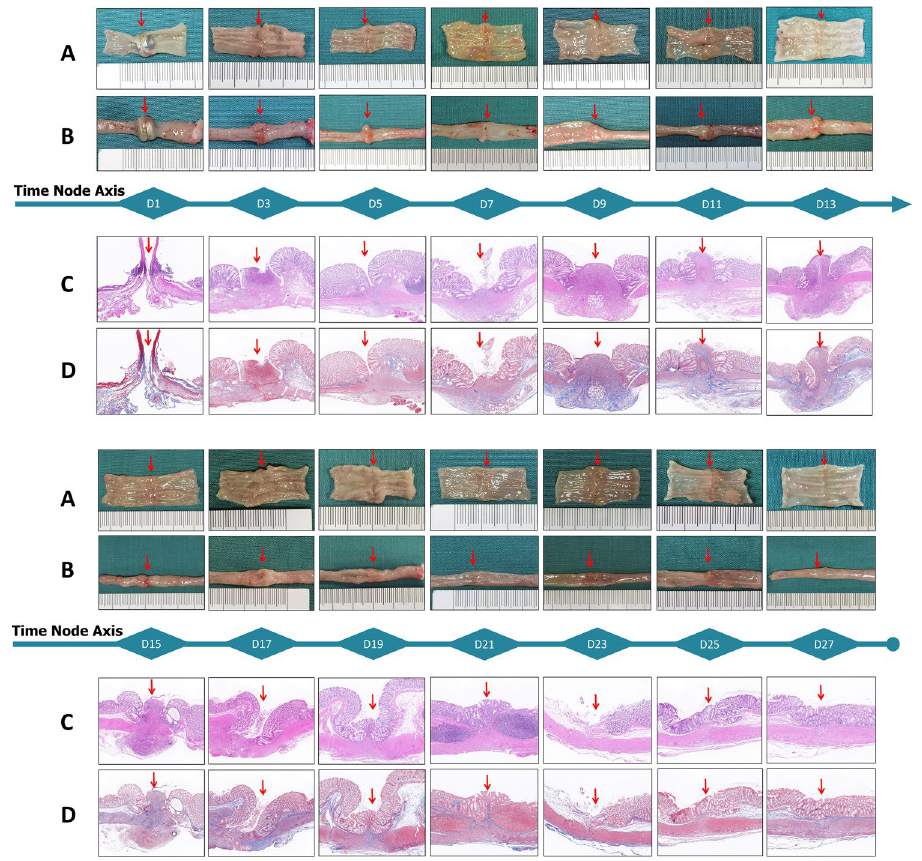
Figure 4. Gross examination showing the anastomotic sites (arrows) on the mucosal side ( A ) and the serosal side ( B ). Histological findings at the anastomotic sites after HE staining (4 ×) ( C ) and Masson’s staining (4 ×) ( D